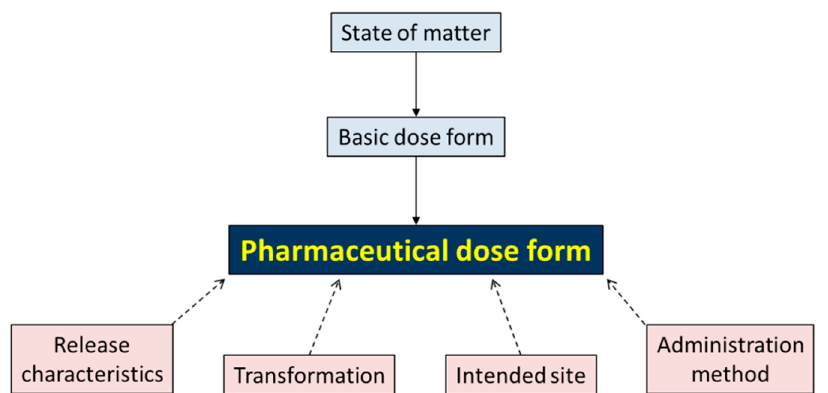
Figure 1. Hierarchy of the pharmaceutical dose form, arranged according to the state of matter and basic dose form, and further characterised by release characteristics, transformation, intended site, and administration method.